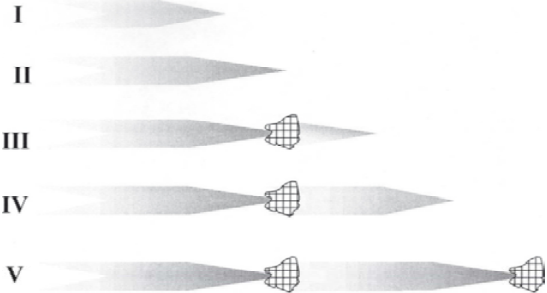
Fig. 10. Dark field image of the Ni amorphous alloy after n = 8 at 77K.